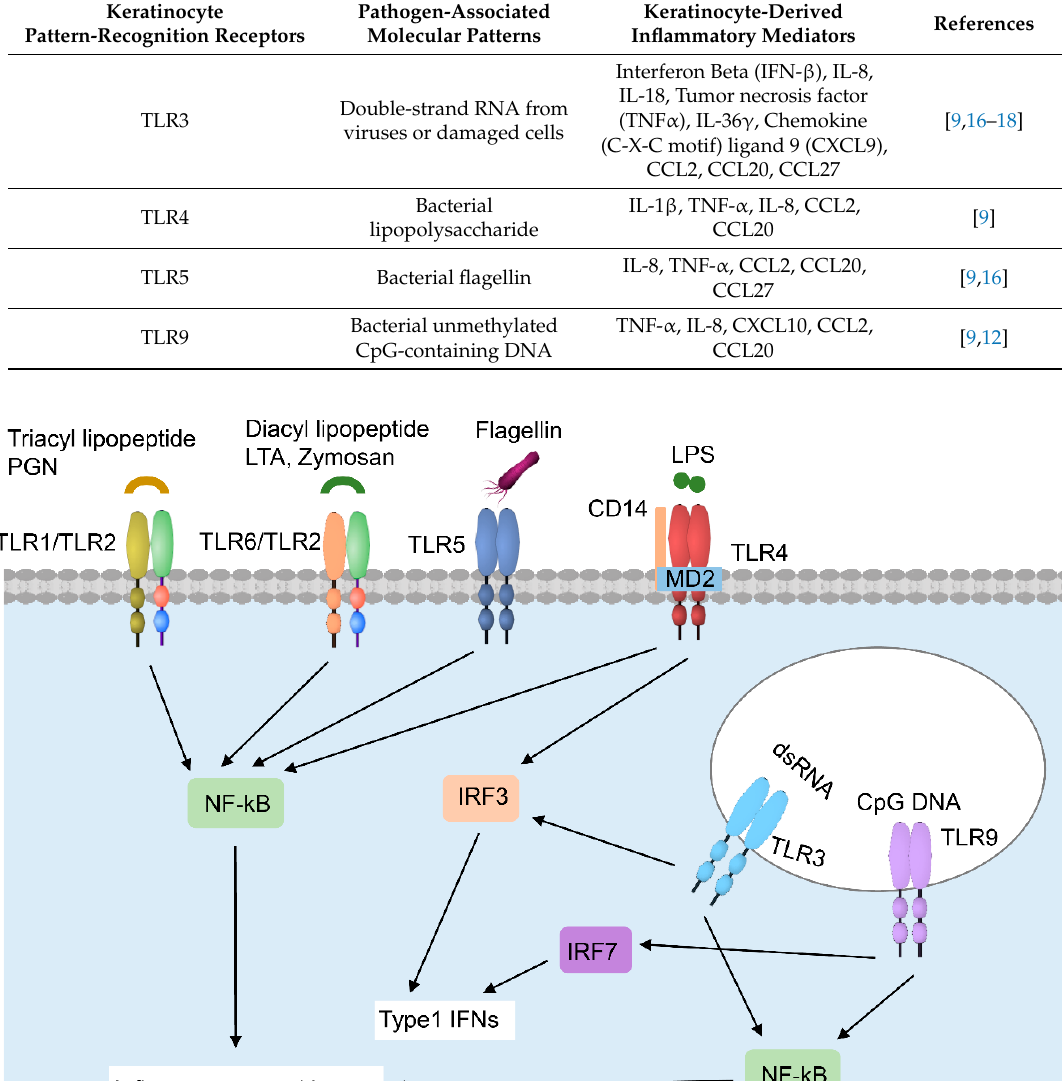
Table 1. Toll-like receptor (TLR)-mediated cytokine and chemokine expression in keratinocytes. Keratinocyte Pattern- Recognition